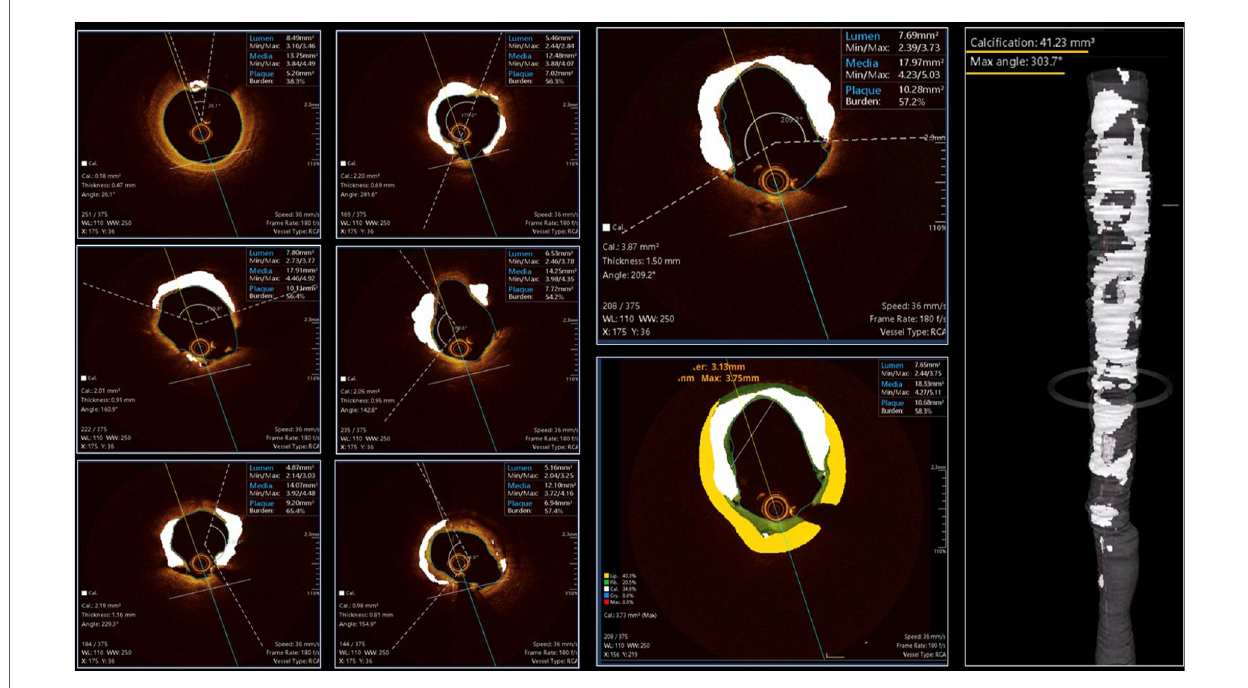
FIGURE 6 Case example applying OCT-plus package for automated detection of calcium burden and distribution. The six panels on the left provide insights about all features of OCT-patterns of calcium. The large two panels in the middle, provide high detailed image of calcium distribution and its possible combination with non-calci fi ed tissues [lipidic (yellow) or fi brotic (green)]. The reconstruction on the right provide clear overview of longitudinal distribution of calcium and provide details about the maximum angle of calcium and total calcium volume in mm 3